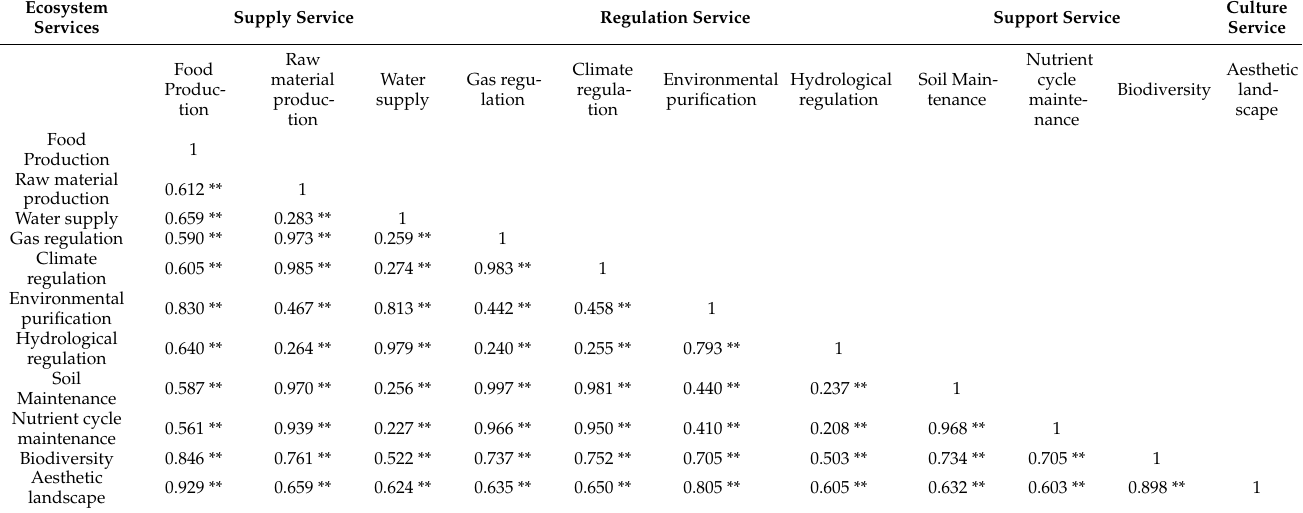
Table 5. Correlation analyses of ecosystem services in the Yarlung Zangbo river basin.